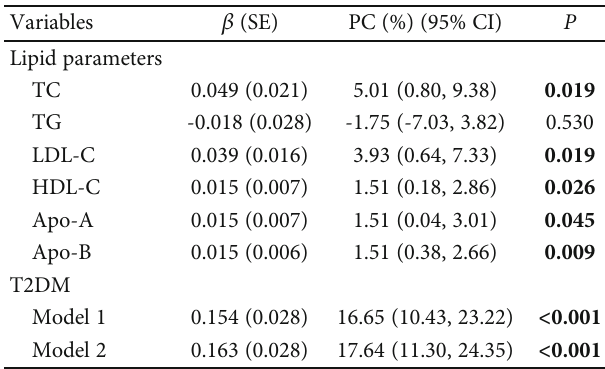
Table 2: Association between KCNQ1 rs2237895 and di ff erent lipid parameters and